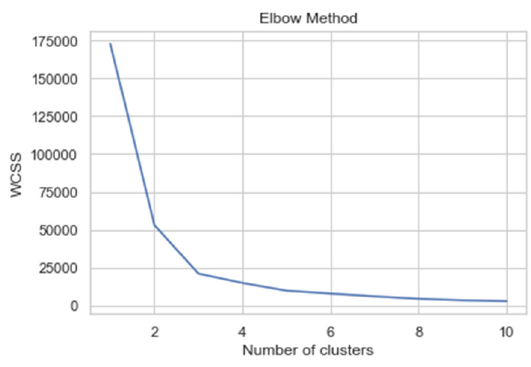
Figure 3. Elbow method results of 24-h locational prices.